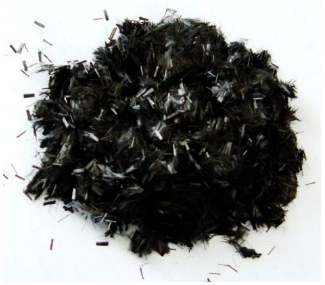
Figure 2. Emulsion powder.